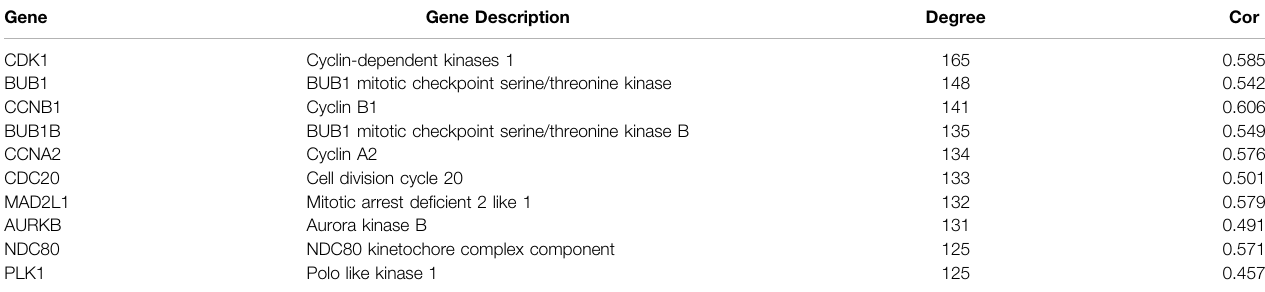
TABLE 5 | Hub genes in the PPI